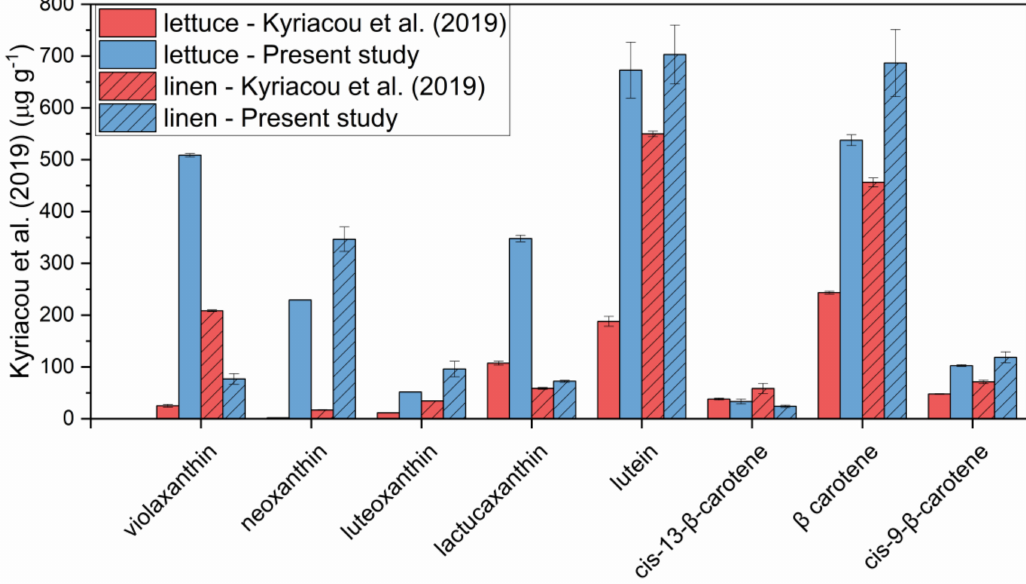
Figure 8. Carotenoids extracted from lettuce and linen microgreens with the method developed in the present study and with a method in literature [24]. Error bars indicate standard deviation.